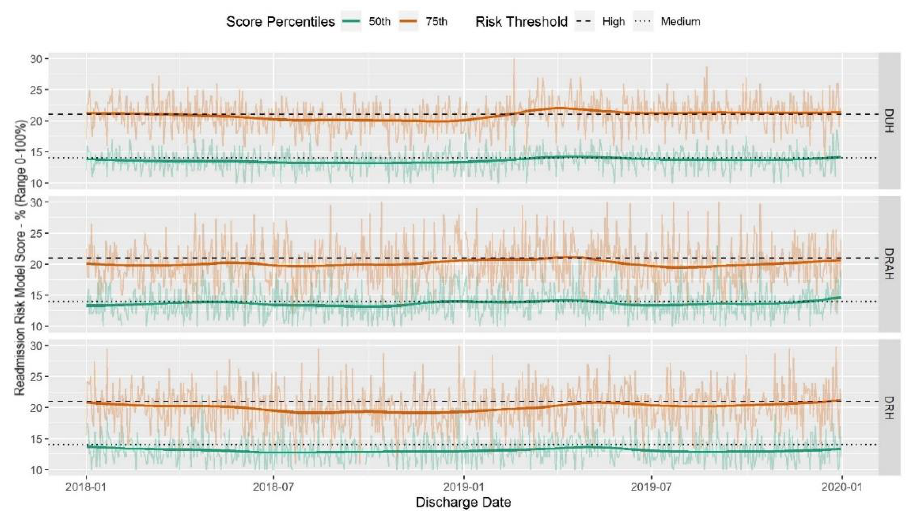
Figure 3. Daily encounter-level risk scores from 1 January 2018–31 December 2019 at three DUHS hospitals. Plots show a LOWESS smoothed curve of the trend over time in bold with the unsmoothed daily readmission rates behind.